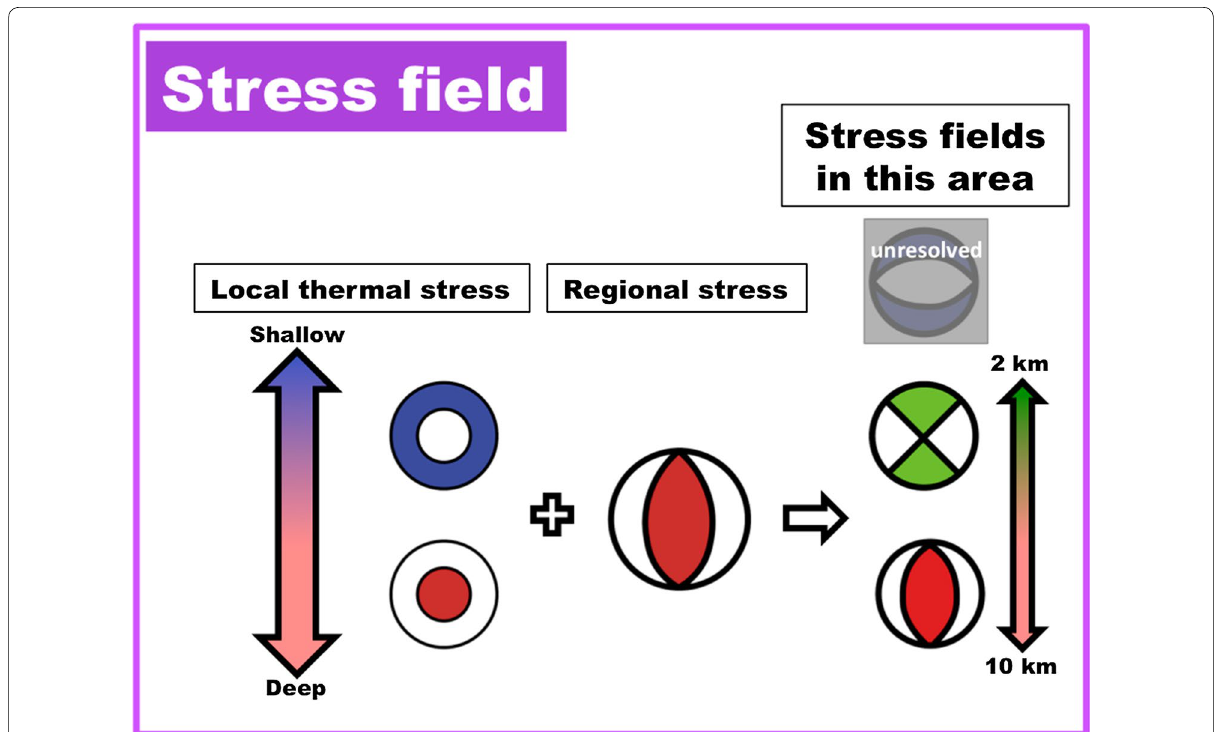
Fig. 12 Conceptual diagram of the stress field proposed in this study. The stress field in this study area can be explained by a combination of local thermal stress and regional tectonic stress. Focal mechanisms are controlled by weak planes such as geological faults under the stress regime shown here. Earthquakes hardly occur at the shallowest depths ( z 2 km) because the normal stresses on the faults are too small. Therefore, the ≤ tensional stress field just beneath the surface is not likely to resolve in a stress inversion that uses focal mechanisms. For this reason, we labeled “unresolved” for the expected stress field in the shallowest part